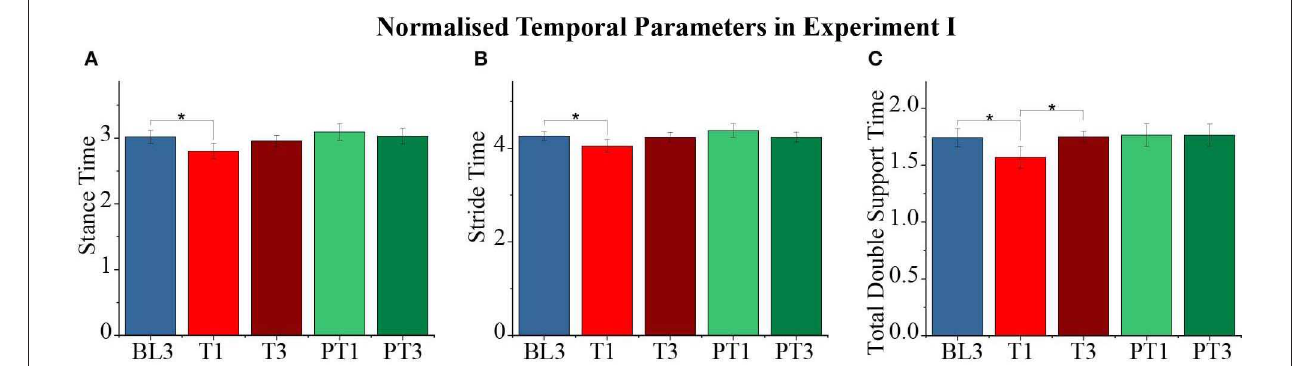
FIGURE 7 | (A–C) Normalized stance time, stride time, and total double support time of the perturbed leg for different sessions. The data presented here are averaged across all participants of Experiment I with standard error (* p ≤